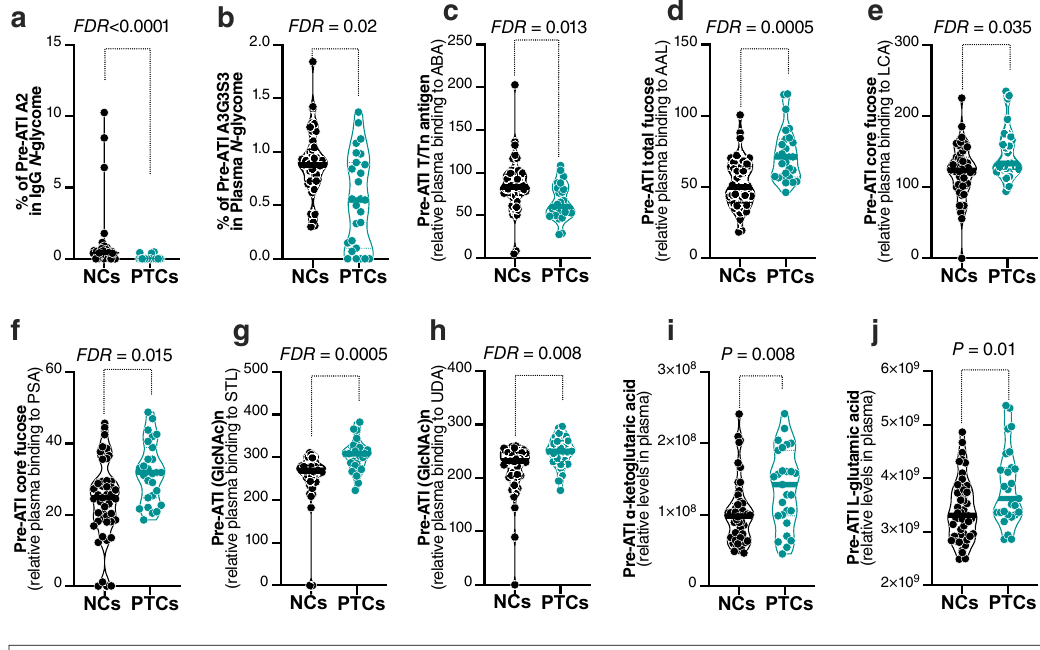
Fig. 6 Plasma glycomic and metabolic markers that distinguish post-treatment controllers (PTCs) from non-controllers (NCs). Pre-ATI levels of three glycan structures are lower in PTCs compared to NCs: ( a ) the disialylated glycans, A2, in the IgG glycome, ( b ) the highly sialylated glycan structure (A3G3S3), and ( c ) T/Tn antigen (measured as binding to ABA lectin). Pre-ATI levels of four glycan structures were higher in PTCs compared to NCs: ( d ) total fucose (binding to AAL lectin) in plasma, ( e , f ) core fucose (binding to LCA and PSA lectins) in plasma, and ( g , h ) (GlcNAc)n (binding to STL and UDA lectins). Pre-ATI levels of two metabolites were higher in PTCs compared to NCs: ( i ) α -ketoglutaric acid and ( j ) L -glutamic acid. All statistical comparisons were performed using a two-sided Mann – Whitney test. Truncated violin plots showing median. False Discovery Rate (FDR) was